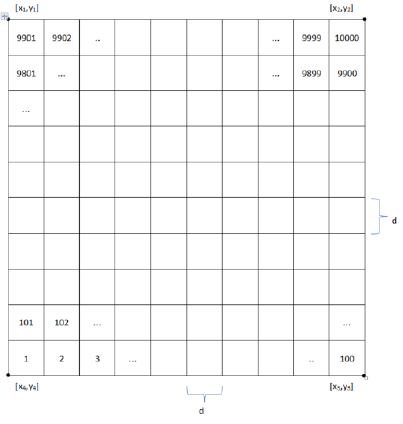
Figure 1. Representation of the Milano grid, with d, = 235 meters 3